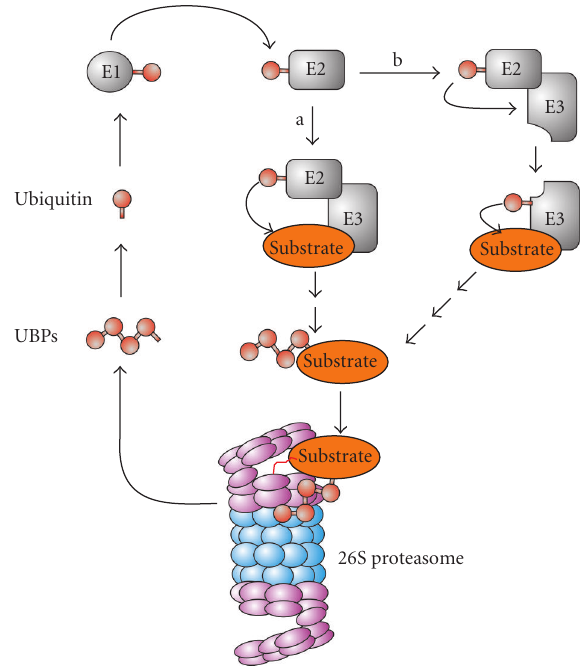
Figure 1: The pathway of ubiquitin-linked degradation of proteins and the 26S proteasome (see